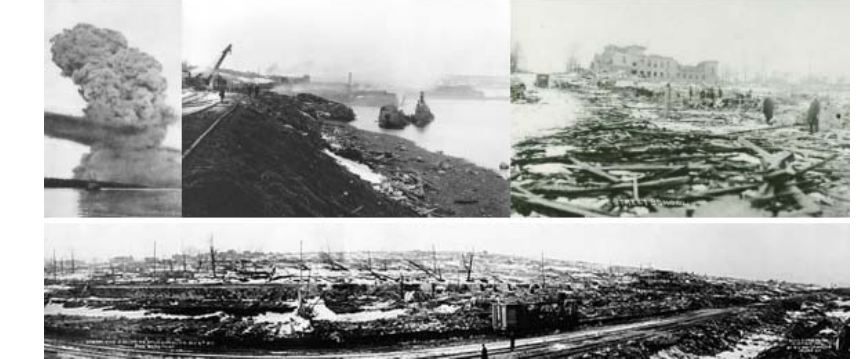
Figure 1 – Disaster in Halifax in 1917, the explosion of the ship and the consequences (Jankovi ć ,